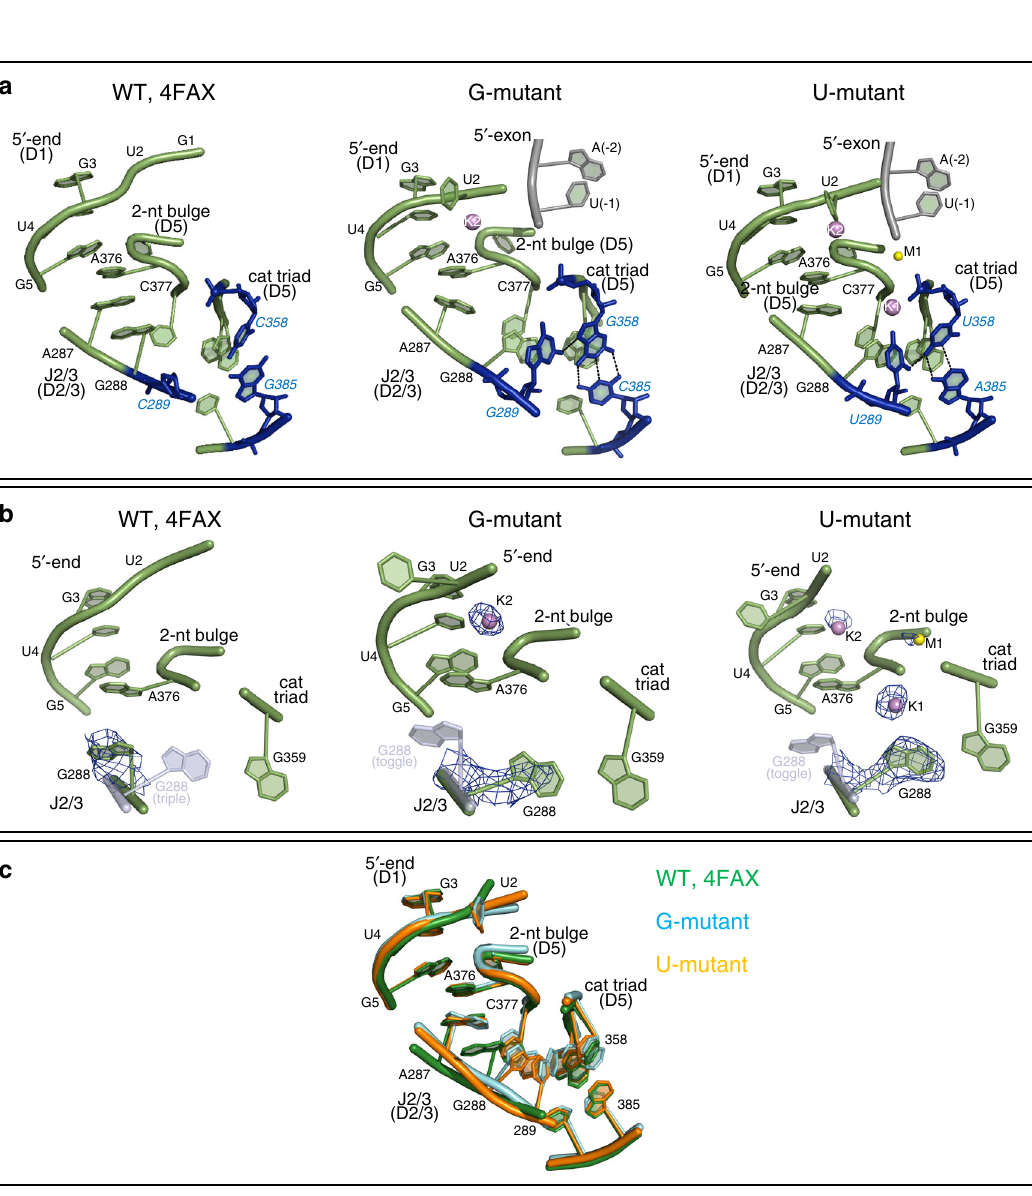
Fig. 2 Crystal structures of the intron in potassium and magnesium. a From left to right: Active site of wild type (WT; PDB id: 4FAR), G-mutant, and U- mutant in the state following 5 ′ -exon hydrolysis. The intron is depicted as a cartoon representation in light green, the 5 ′ -exon is in gray, and the mutated triplex is in blue (black dotted lines indicate H-bonds forming the triple helix). b F o − F c simulated-annealing electron density omit-maps calculated by omitting J2/3 residues (nt 287 – 289) and the M1-M2-K1-K2 metal cluster from each of the structures depicted in ( a ). Positive electron density peaks within 3 Å from the omitted atoms are depicted as blue mesh at a contour level of 3 σ . The toggled conformation of G288 (from PDB id: 4FAX) is depicted as a semi-transparent light blue cartoon representation for reference. c F o − F c simulated-annealing electron density omit-maps calculated by omitting G1 from each of the structures depicted in ( a ). Positive electron density peaks within 3 Å from the omitted atoms are depicted as blue mesh at a contour level of 3 σ . G1 is unresolved in the structure of the U-mutant. d Superposition of the active sites of the structures depicted in ( a ). e Secondary structure of the wild-type O. iheyensis group II intron with catalytic site elements highlighted by red boxes and nucleotides not present in the crystal structures in gray.